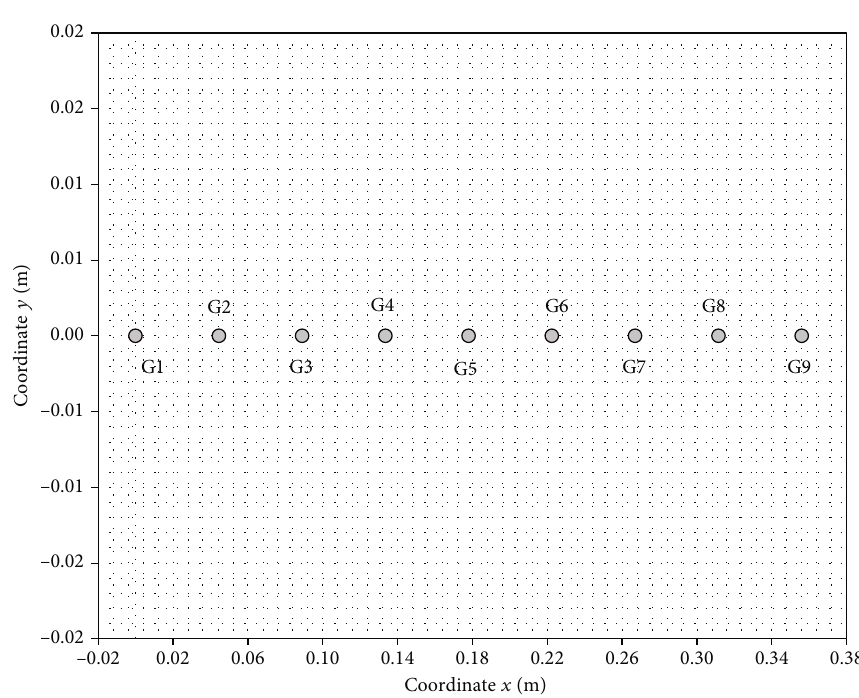
Figure 11: The measuring points for the gantry (phases G I, G II, and GIII are the